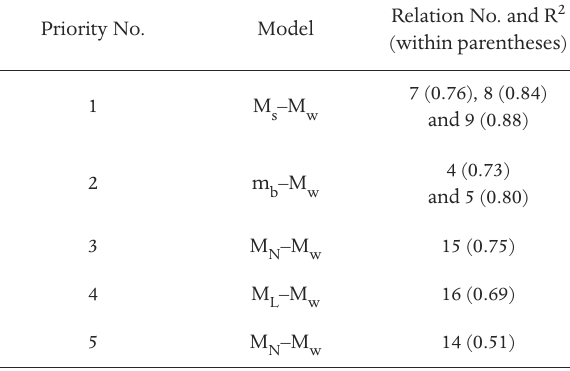
Table 6. Magnitude conversion relations applied to unify the cata- log in order of